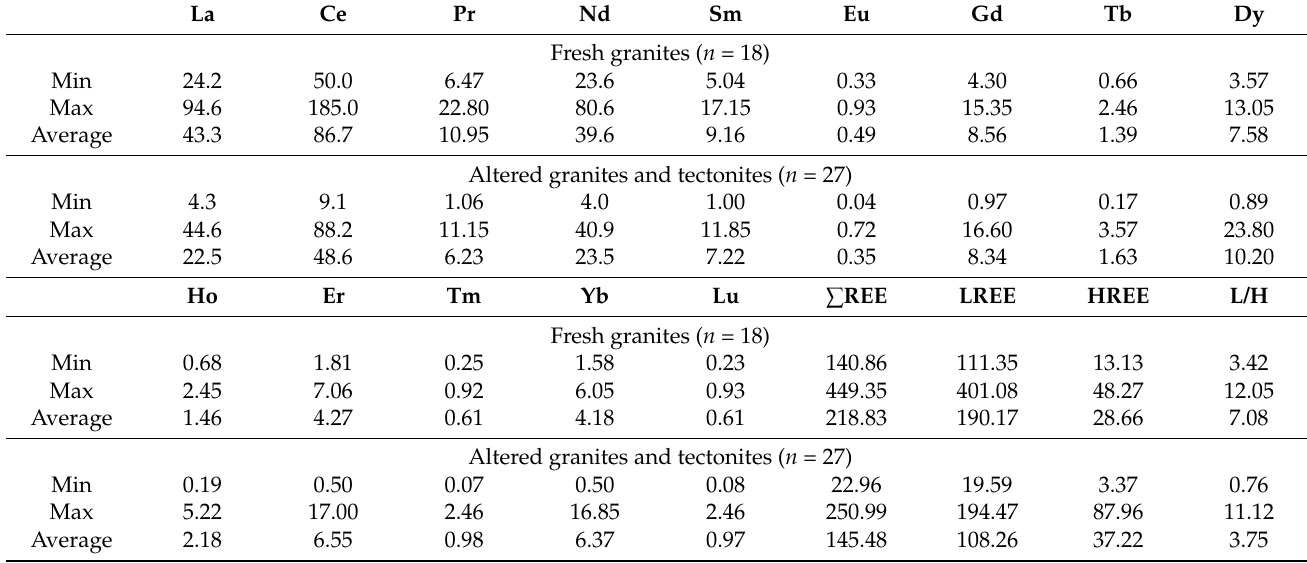
Table 4. Main results of REE (ppm) of granite samples from